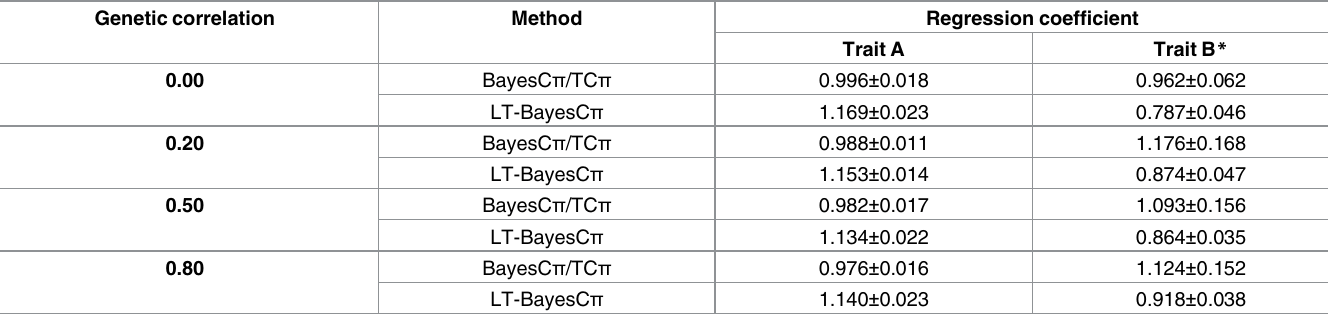
Table 4. Regression coefficients of TBVs on GEBVs in generation 3 in four scenarios with different genetic correlations. Genetic